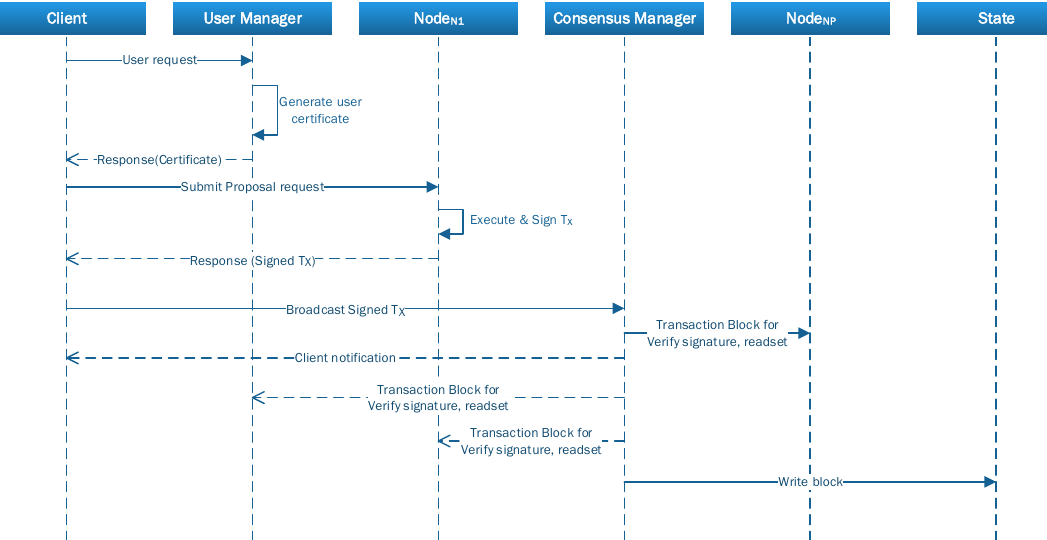
Figure 7. Transaction flow in the proposed drug supply chain management in a medical blockchain